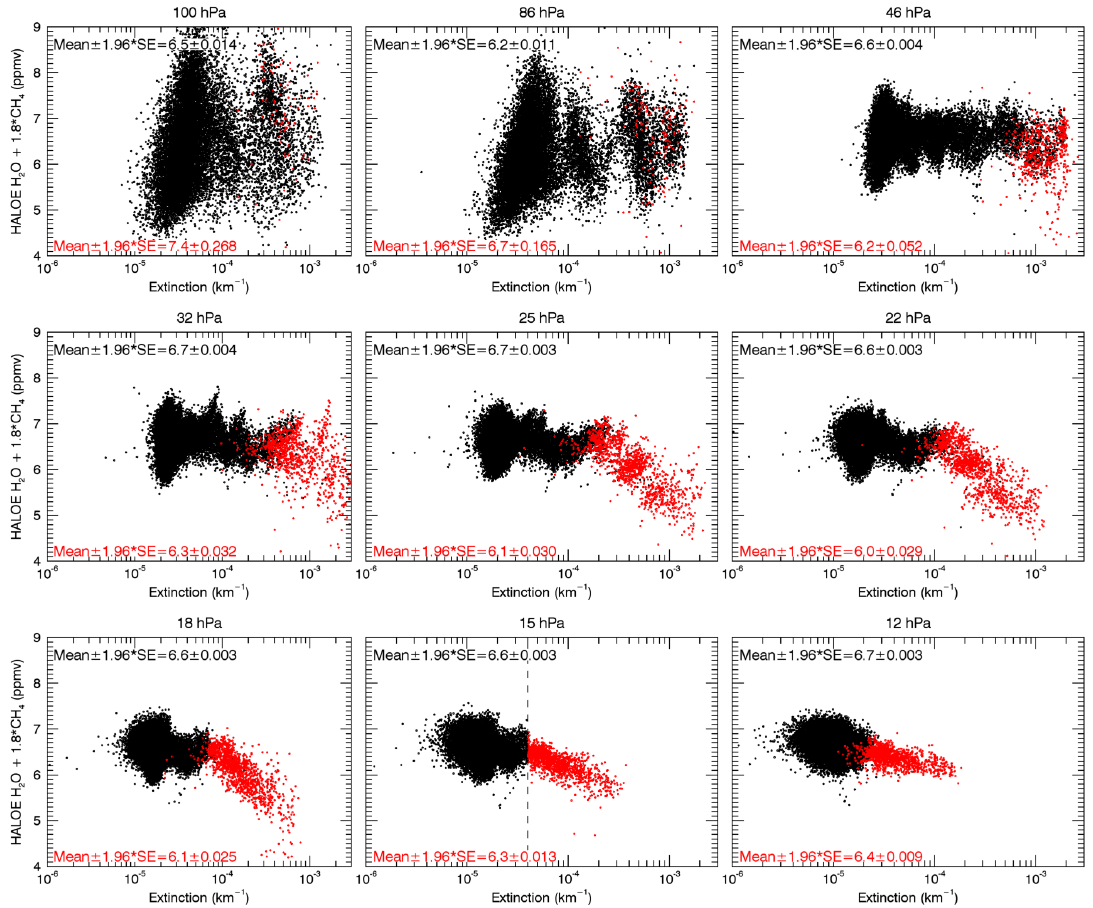
Figure 2. HALOE “total water” (H 2 O + 1.8 · CH 4 ) vs. aerosol extinction in the HALOE NO channel for tropical (30 ◦ S–30 ◦ N) data, segregated by events with low extinction ( < 4 × 10 − 5 km − 1 , black) and high extinction ( > 4 × 10 − 5 km − 1 , red) at 15hPa. The mean ± 1.96 · standard error of the mean (i.e., the 95% confidence interval) is given for each level and extinction